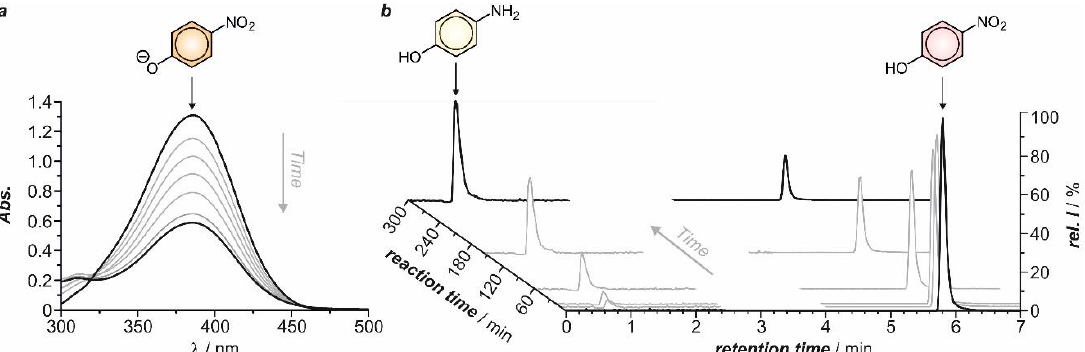
Figure 6. Evolution of the absorption spectrum ( a ) of 4-NPO during the electrochemical reduction of a 5.25 mM aqueous solution of 4-NP (0.1 M Na 2 SO 4 ) at pH = 2 on a silver working electrode at 25 °C (E = −0.550 V). The aliquots were alkalinized (pH = 13) with 0.1 M NaOH prior registering the absorption spectra. Evolution of the HPLC chromatogram ( b ) during the electrolysis of the same solution on a gold working electrode at 25 °C (E = −0.465 V).